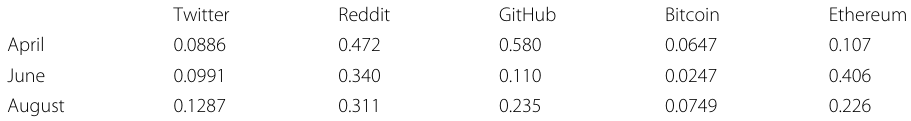
Table 2 Average MAPE of time series for predictions during the months of April, June, and August in 2017 Twitter Reddit GitHub